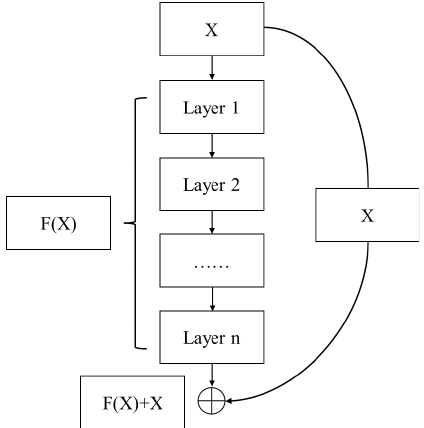
Figure 4. Structure of residual network.